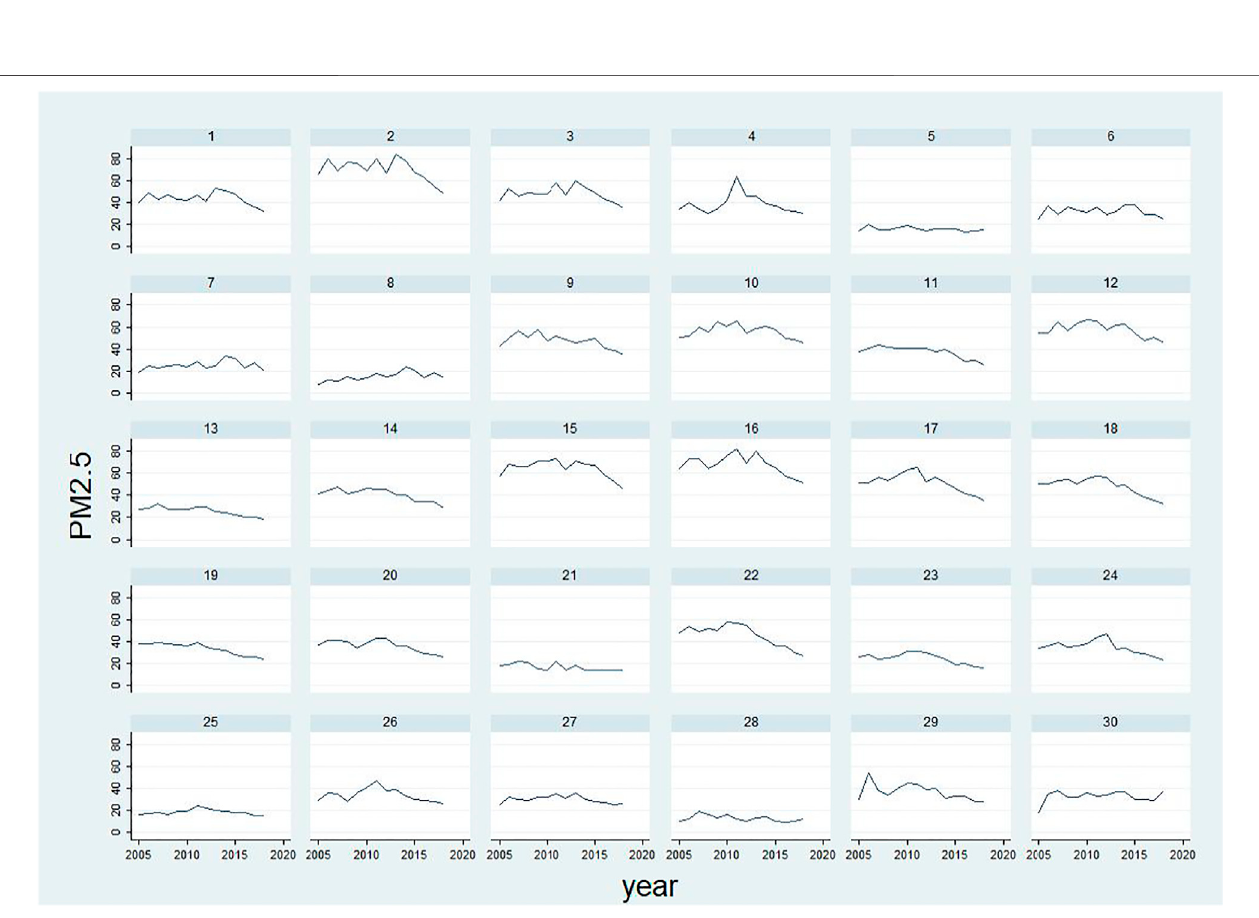
FIGURE 2 | Time trend of PM2.5 in 30 provinces from 2005 to 2018.